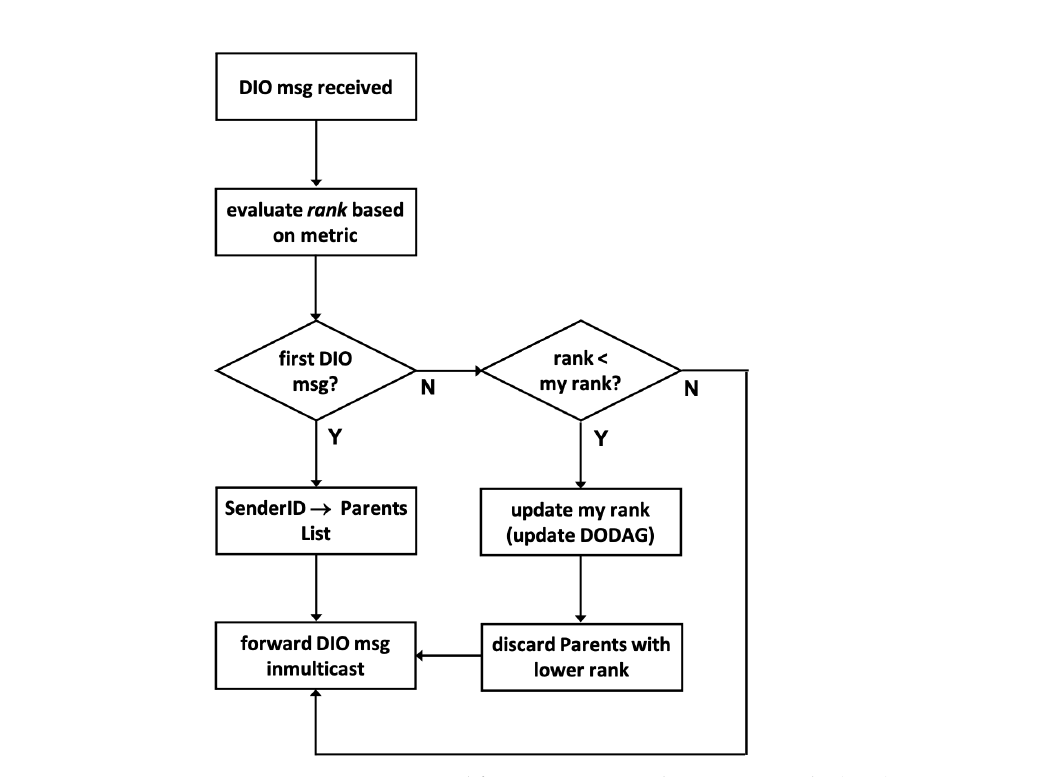
Figure 1. Routing Protocol for Low-Power and Lossy Networks (RPL) Destination Oriented Directed Acyclic Graph (DODAG) management flow chart upon receiving a DODAG Information Object (DIO)